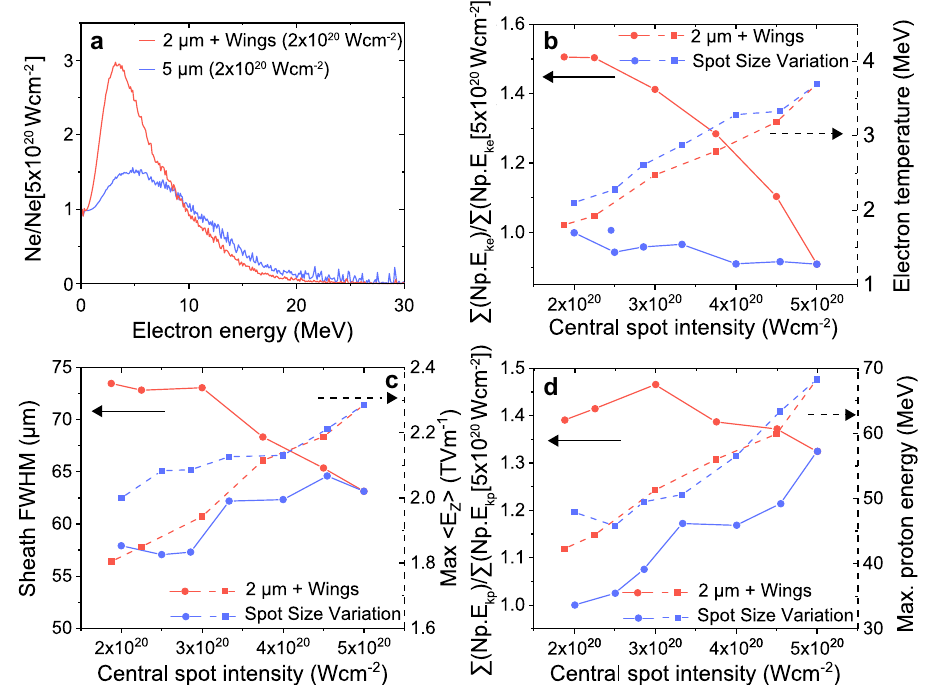
Figure 4. Simulation results illustrating the influence of spatial-intensity contrast. ( a ) Electron spectra for a central spot intensity of 2 × 10 20 W cm − 2 normalised to the corresponding spectra for 5 × 10 20 W cm − 2 at d = 2 µ m , for an example case in each of the central spot diameter ( d ) and wing energy ( d = 2 µ m ) scans. ( b ) Total energy in the fast electron population (solid), normalised to the corresponding values for the d = 5 µ m focal spot case, and electron temperature (dashed). ( c ) Transverse size FWHM (solid) and maximum longitudinal electric field strength (dashed) of the spatially averaged rear surface sheath field. ( d ) Total energy of the accelerated protons (solid), normalised to the 5 µ m focal spot case, and maximum proton energy (dashed). In ( b–d ) plots are as a function of central spot intensity changed by varying d (blue) and wing energy content for d = 2 µ m (red). The total laser pulse energy is fixed in all cases.